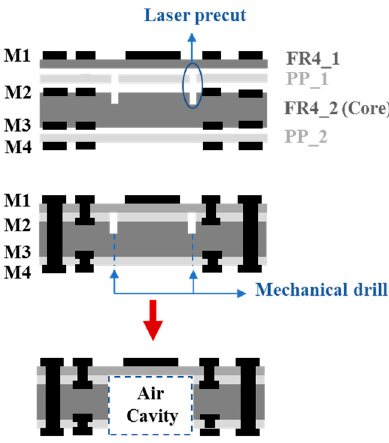
Figure 13. Manufacturing process of the antenna with an air-filled cavity.